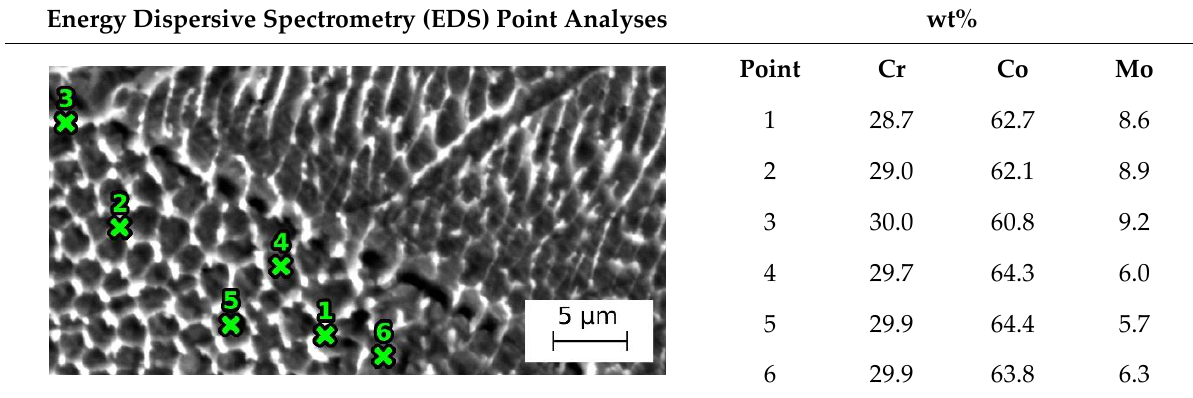
Figure 1. Initial microstructure of the 3D-printed Co-Cr-Mo alloy: ( a ) XY section (optical microscopy (OM) micrograph; ( b , c ) XZ section (OM); ( d ) scanning electron microscopy (SEM) micrograph.